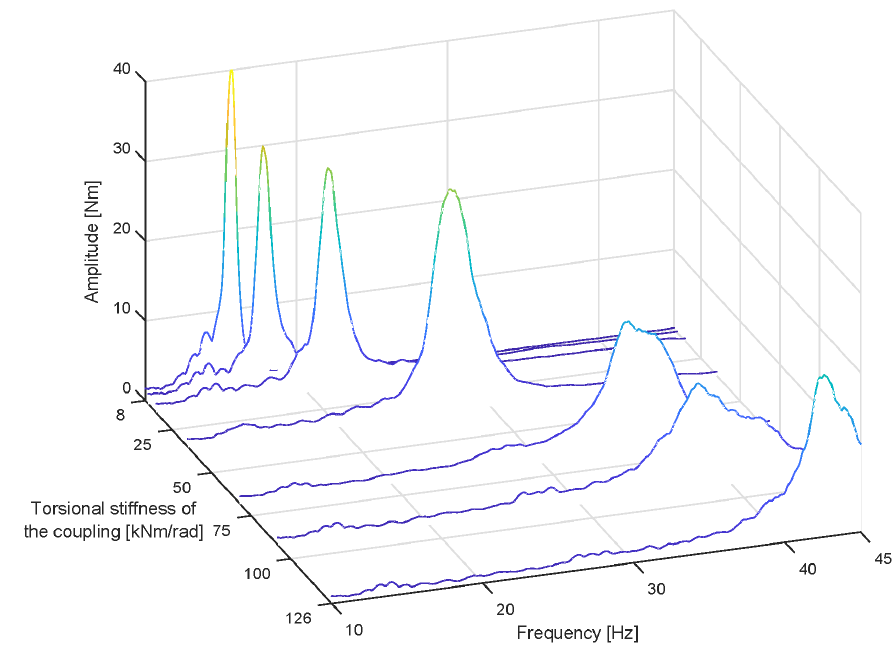
Figure 5. Effect of the torsional stiffness of the coupling on the torsional natural frequency. The fre- quency domain transforms of the measured torsional vibrations obtained from the torque transducer are plotted as a function of torsional stiffness of the coupling. Each frequency curve presents averaged data from all the ten measurements with that torsional stiffness of the coupling. The torsional natural frequencies were identified from the vibration amplitude